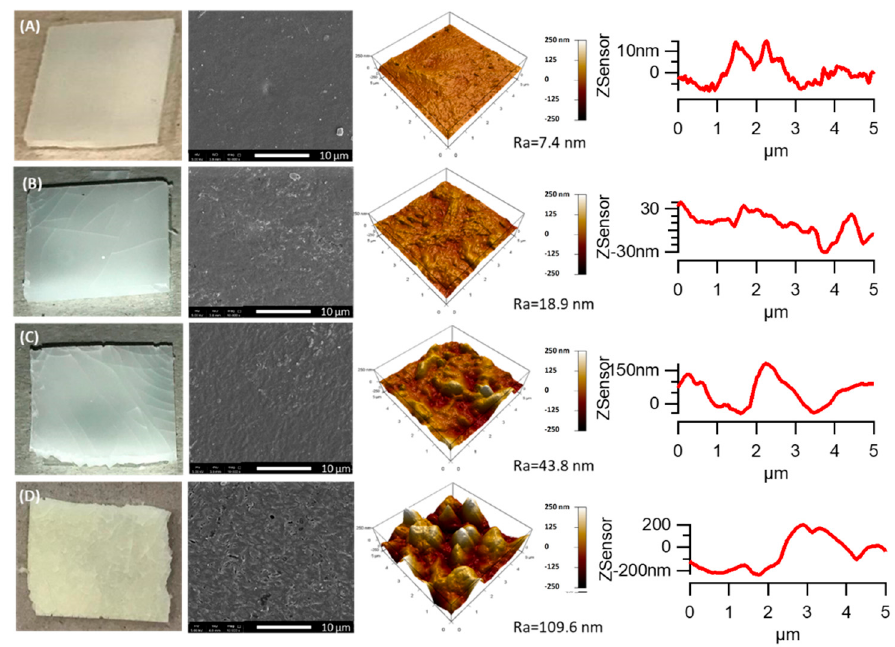
Figure 1. SEM and atomic force microscopy (AFM) images of the poly(3-hydroxybutyrate-co-3-hydroxyvalerate) (PHBV) samples before ( A ) and after accelerated weathering: ( B ) 500 h; ( C ) 1000 h; and ( D ) 2000 h. Note: R a represents the roughness parameter.